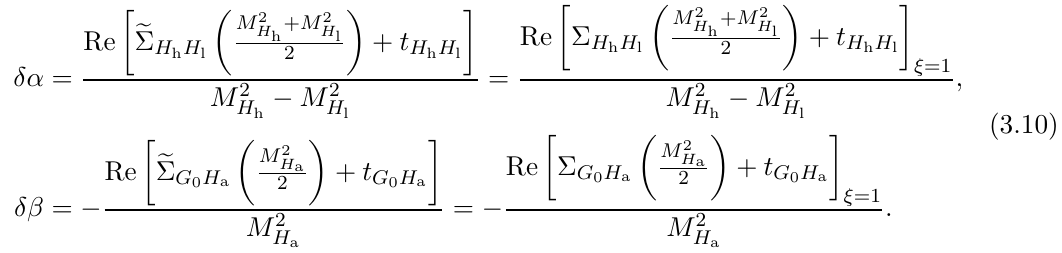
Figure 1 . The vertices that are used for the determination of the counterterms (cid:14)(cid:12) , (cid:14)(cid:11) or (cid:14)(cid:30) with (cid:30) = (cid:11) (cid:12) are shown with their corresponding Feynman rules. The symbol e is the elementary (cid:0) electric charge, M W ( m (cid:28) ) is the mass of the W boson ( (cid:28) lepton) and s W = of the mixing